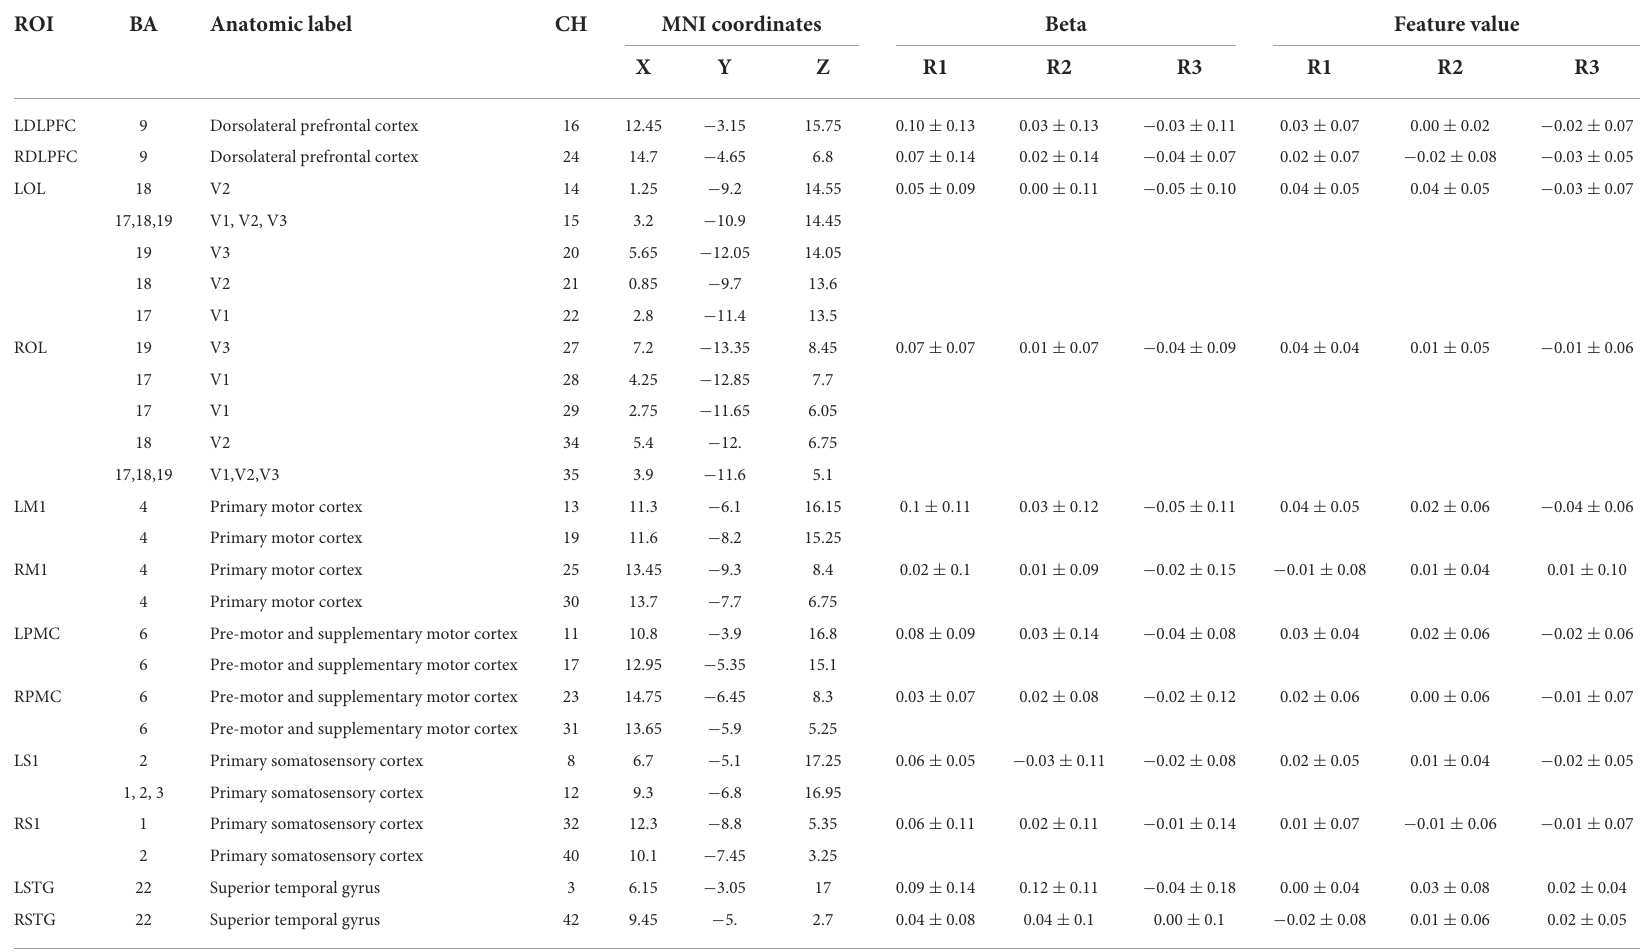
TABLE 2 Cortical activation [ β and featured values (FVs)] during different virtual reality (VR) interactive modes.